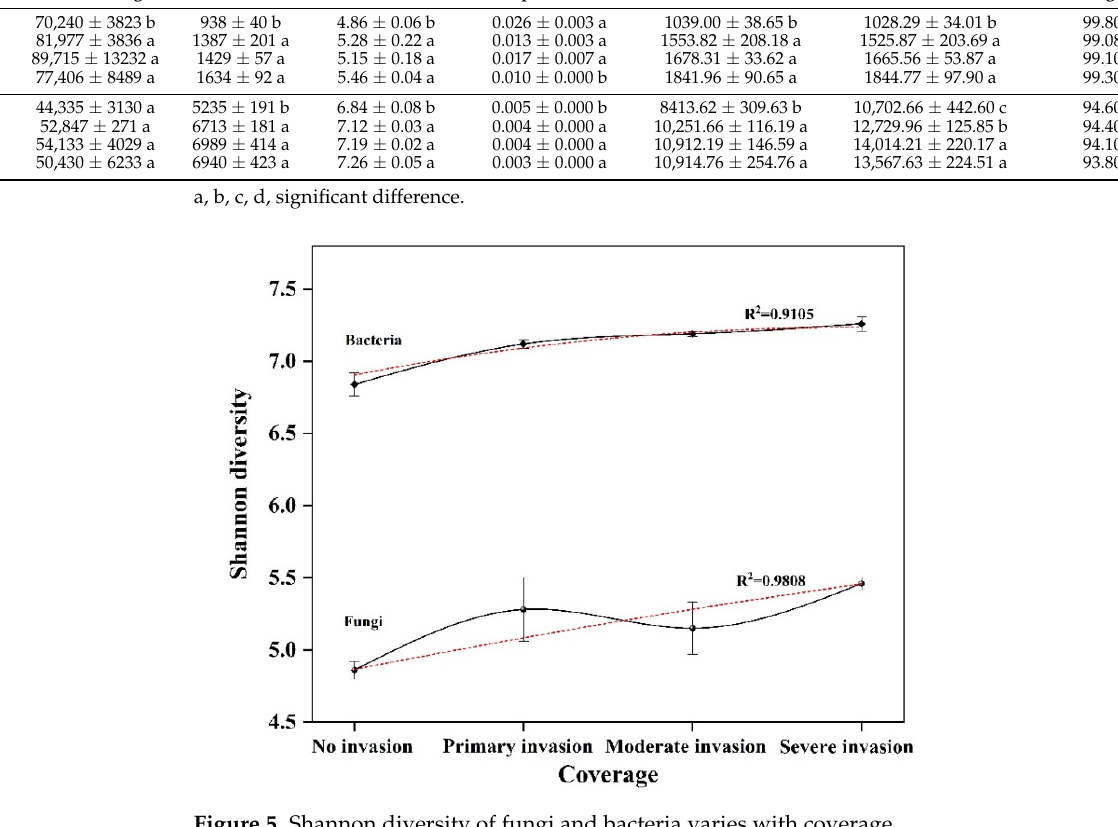
Figure 5. Shannon diversity of fungi and bacteria varies with coverage.